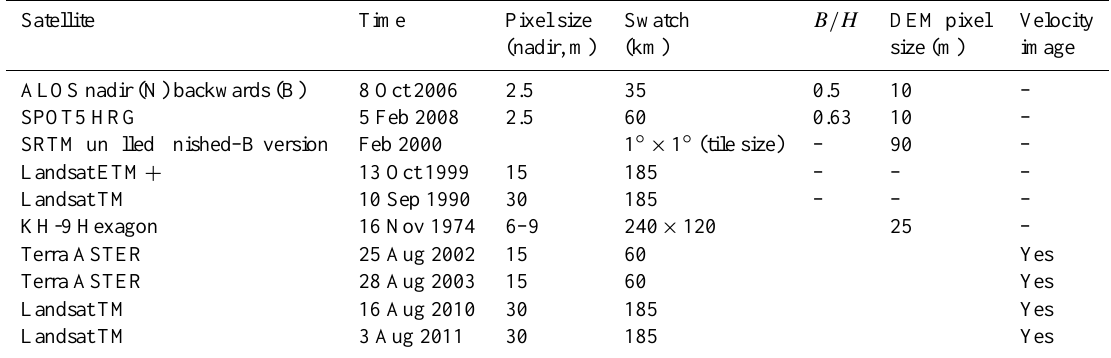
Figure 1. Location and topography of Southern Inylchek Glacier (SIG) and Northern Inylchek Glacier (NIG). TS is Tian Shan Station; K is Koilu Station. Table 1. List of utilized satellite images and data